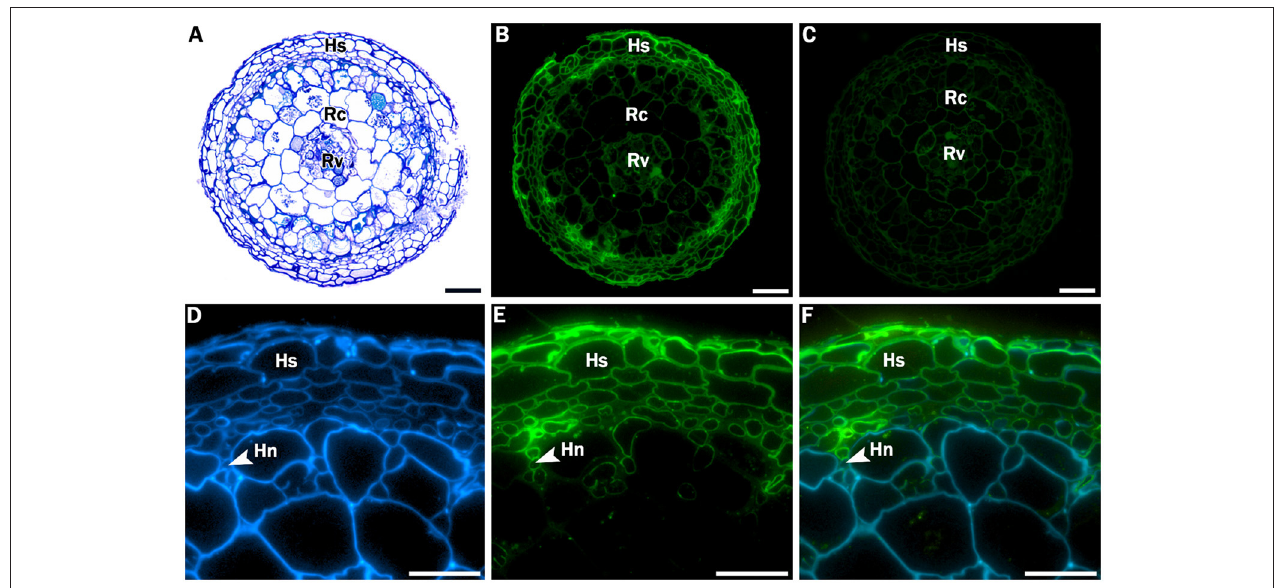
FIGURE 2 | Stained and labeled transverse Crataegus monogyna root sections. (A) Overview section stained with toluidine blue O. (B) Equivalent section labeled with WGA-FITC; cell walls of the hyphal sheath are clearly labeled. (C) Equivalent control section showing weak auto fluorescence of plant root cell walls. (D) Detail of section labeled with calcofluor white, which stains both hyphal and plant cell walls. (E) Equivalent section labeled with WGA-FITC, which clearly binds to the cell walls of the hyphal sheath and the Hartig net. (C) Overlay of image (D) and (E) . Hs: hyphal sheath; Rc: root cortex; Rv: root vascular cylinder; Hn: Hartig Net; Scale bars: (A-C) : 100 µ m; (D-F) : 40 µ